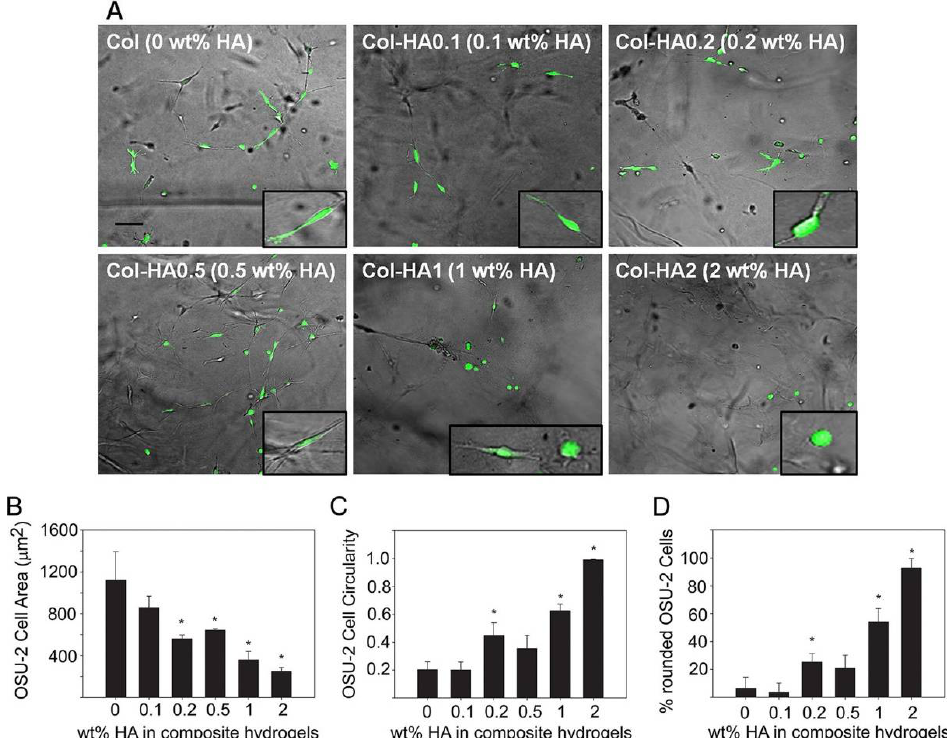
Figure 4. Glioblastoma cell morphologies and migration when cultured on different substrates. OSU-2 glioma cells were cultured on collagen I and III and HA composite hydrogels with different concentrations of HA. Cell morphologies shown in ( A ) were quantified via cell area ( B ), circularity ( C ), and roundness ( D ). Increased HA content led to lower cell area but increased cell circularity and roundness. The scale bar in ( A ) indicates 100 μm, * in ( B – D ) represents a p -value < 0.05 compared to 0% HA condition. Figure reprinted/adapted with permission from Ref. [171]. Copyright